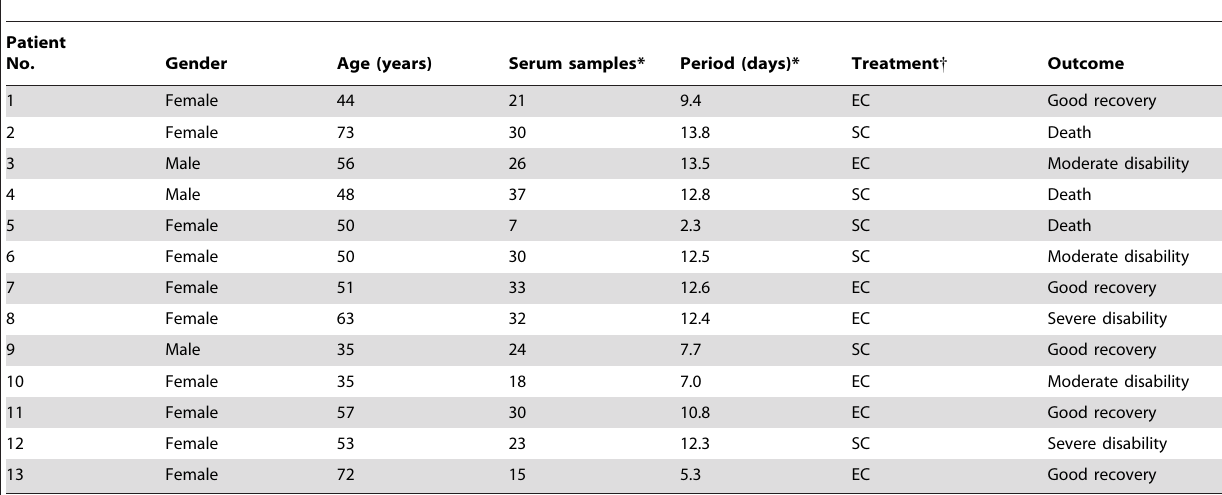
Table 2. Characteristics of patients with aneurysmal subarachnoid hemorrhage (n=13).